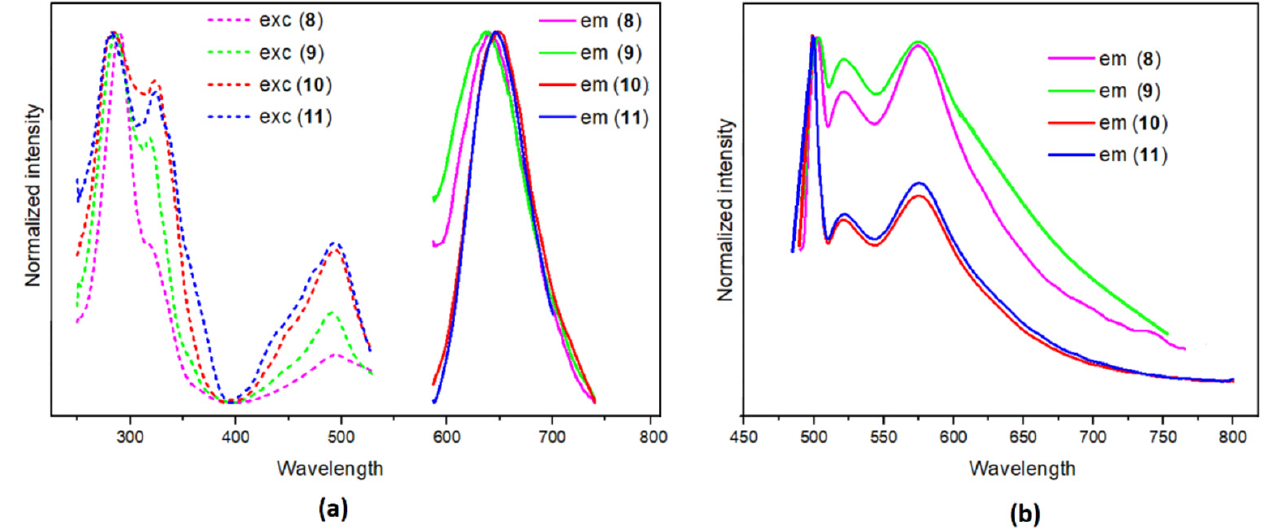
Figure 4. ( a ) Intensity-normalized emission and excitation spectra of ( 8 )–( 11 ) in acetonitrile at 298 K. ( b ) Intensity-normalized solid state emission spectra of ( 8 )–( 11 ) at 298 K.